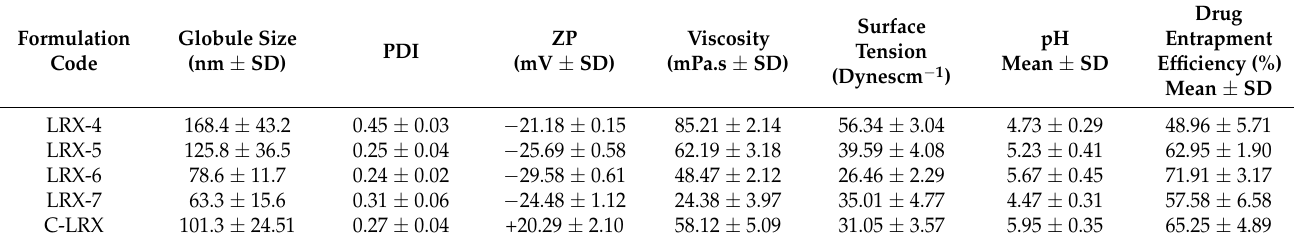
Table 4. Physicochemical characterization of selected LRX formulations.